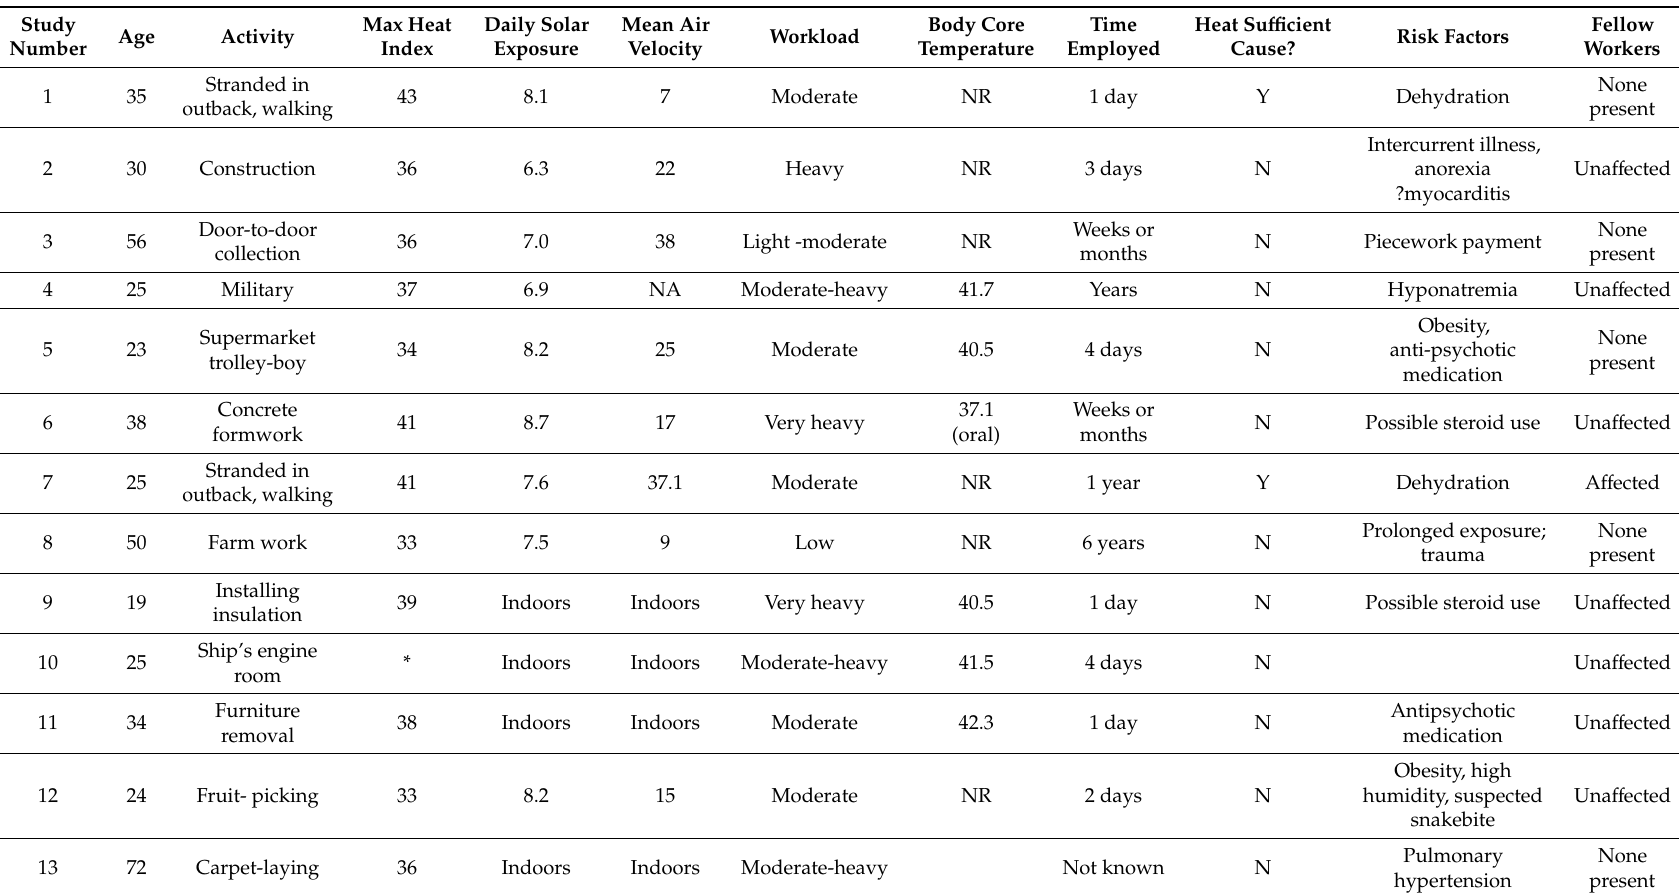
Table 1. Summary of heat stress parameters and risk